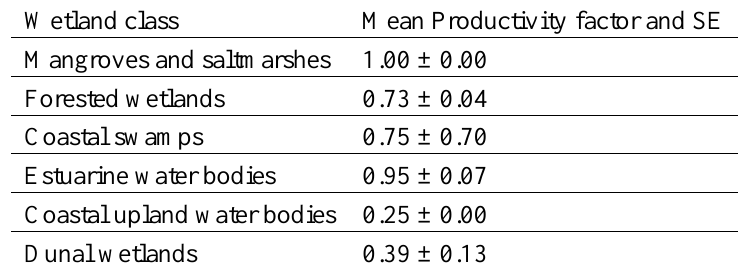
Table 6. Mean productivity factors and standard error for the wetland classes.